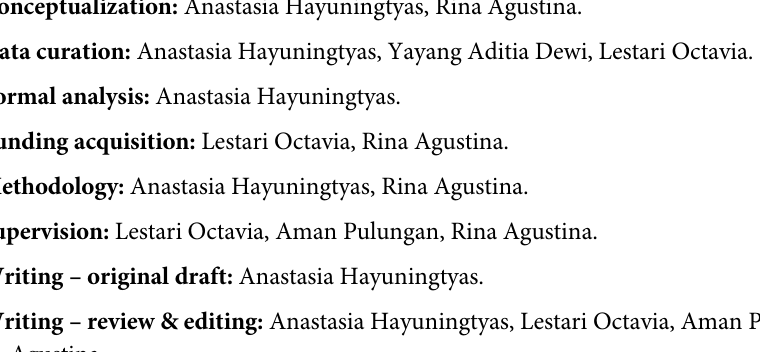
S1 Table. Sample representativeness